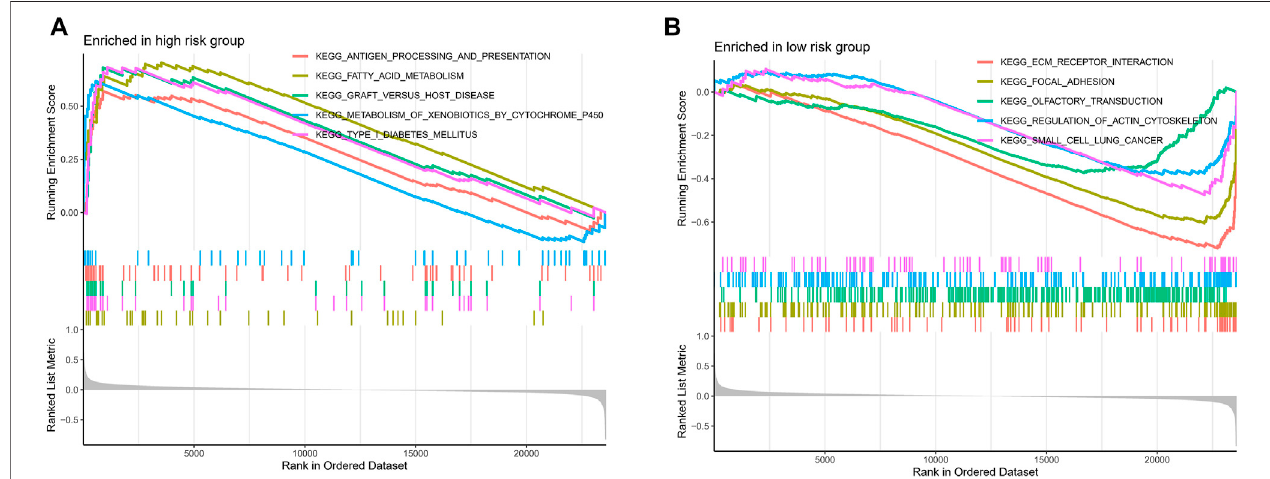
FIGURE 8 | The GSEA analysis of the high- and low-risk groups. The GSEA pathway enrichment analysis of the high- (A) and low-risk (B) groups.